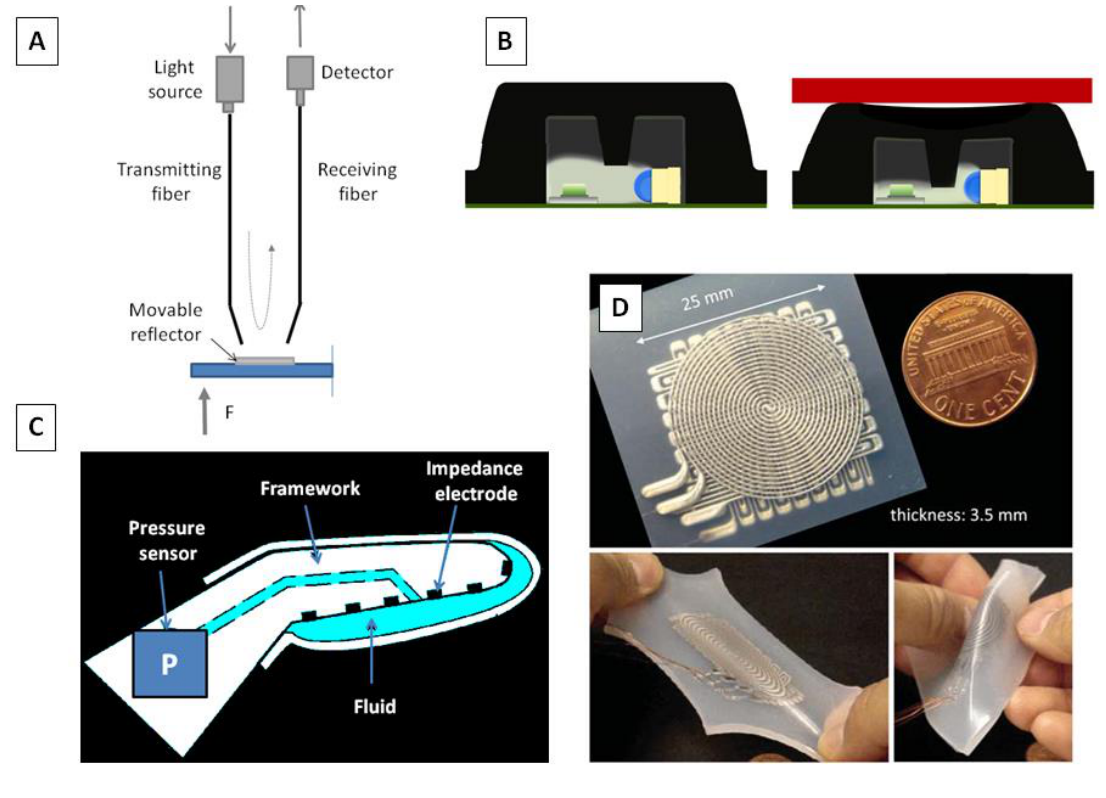
Figure 5. ( A ) Example of fiber-optic based pressure sensor for minimally invasive surgery; ( B ) in-shoe optomechanical transducer of foot pressure [109]; ( C ) fluidic (readapted from [55]) and ( D ) microfluidic tactile sensors for artificial skin